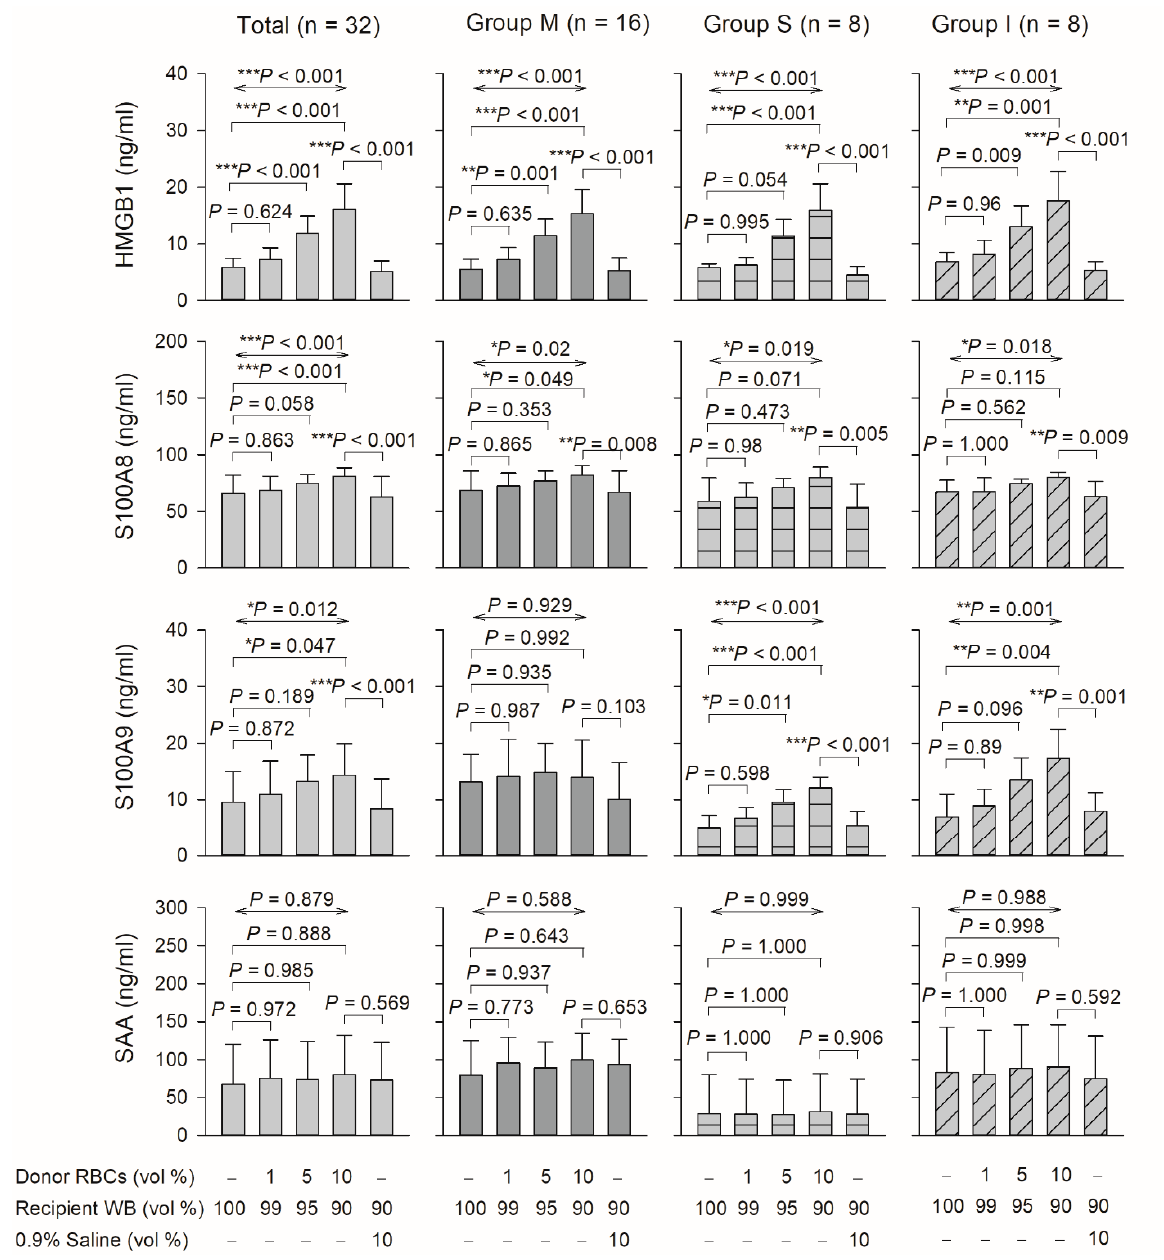
Figure 3. Effect of DAMPs (HMGB1, S100A8, S100A9, and SAA) in the plasma prepared from mixing donor red blood cells and recipient whole blood on total blood mixing and groups M, S, and I. HMGB1, high mobility group box-1; SAA, serum amyloid A; RBCs, red blood cells; vol, volume; WP, washed platelets. Data are expressed as mean ± SD. * p < 0.05, ** p < 0.01, *** p < 0.001. 3.4. Effect of Proinflammatory Cytokines Downstream of the TLR4 Signaling Pathway in Plasma Levels of total LPS-binding protein involved in TLR4 signaling ( p = 0.526) and endpoint proteins, namely total TNF- α , IL-1 β , and IL-6 ( p = 0.998, 0.806, and 0.87, respectively), were not elevated after blood mixing (Figure 4).